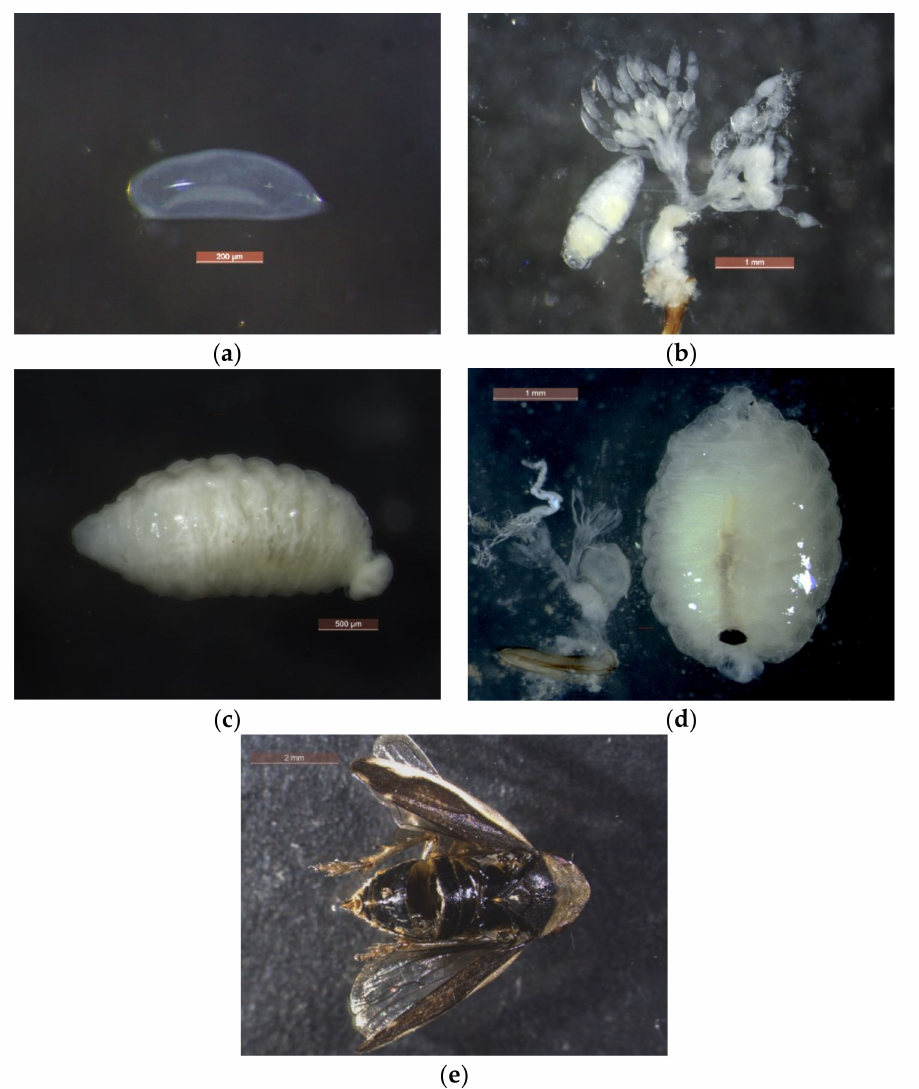
Figure 4. Developmental stages of the parasitoid Verrallia aucta in the host Philaenus spumarius : ( a ) egg dissected from a parasitized spittlebug female; ( b ) first instar larva (on the left) and ovarioles of the parasitized spittlebug female (on the right); ( c ) young larva with terminal vesicle on the right; ( d ) second instar larva with dark posterior spiracular plate (on the right) and degenerated ovarioles of the parasitized spittlebug female (on the left); and ( e ) the body of P. spumarius female after the emergence of V. aucta mature